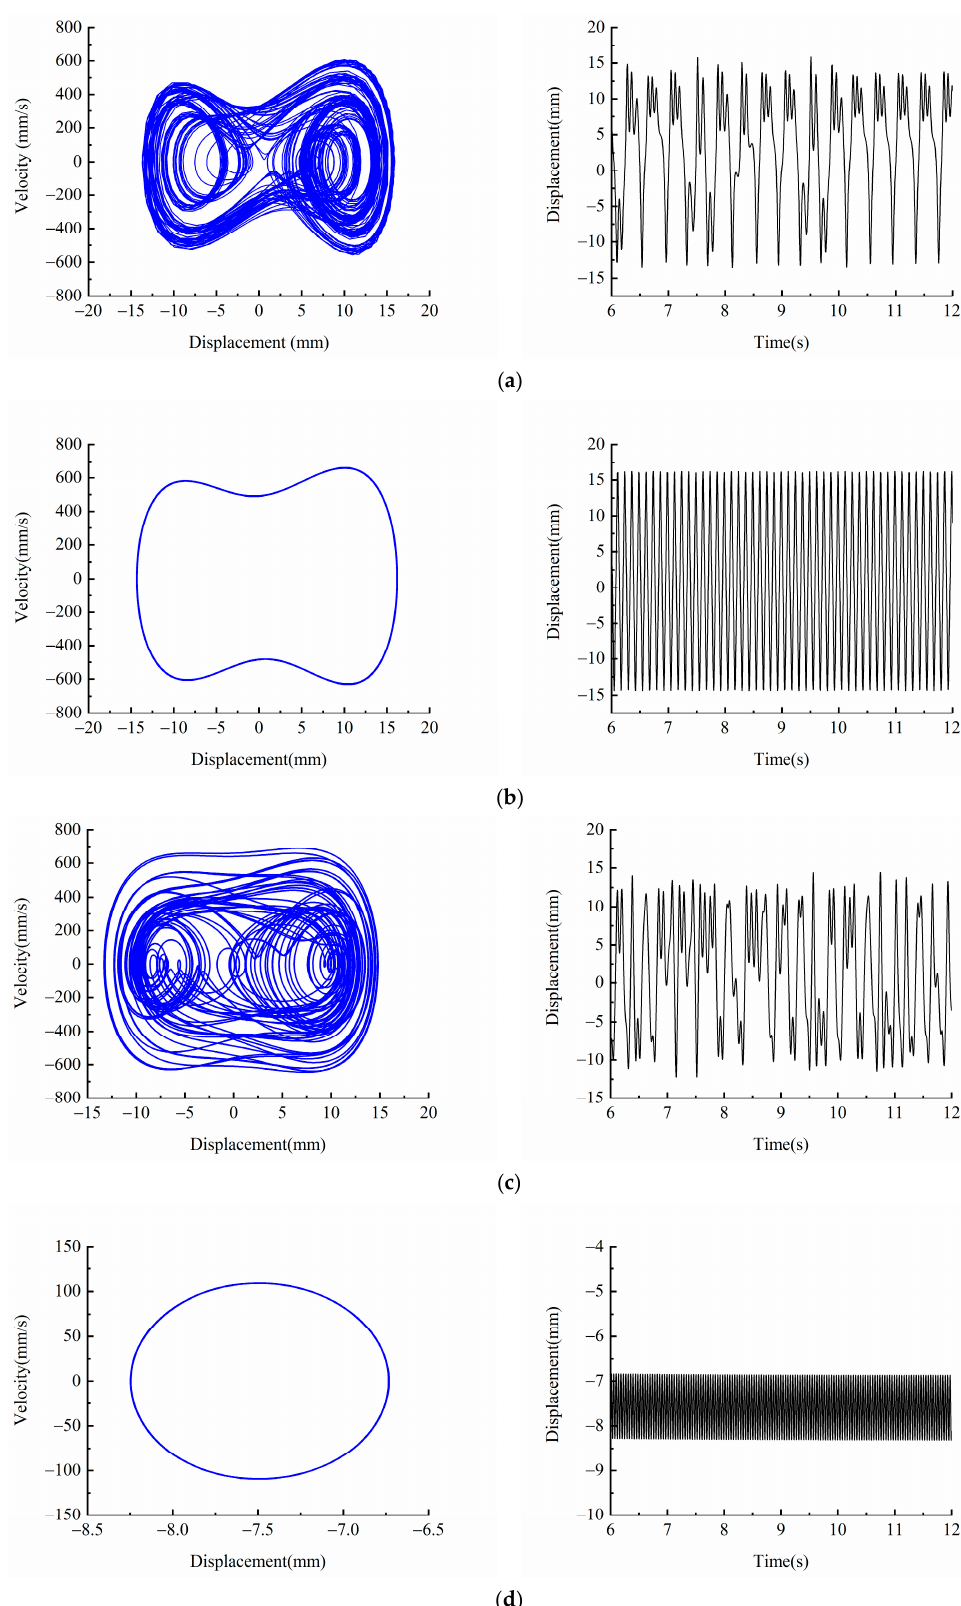
Figure 8. Phase portrait and time-displacement diagram of different excitation frequency 𝑓 : ( a ) 𝑓 = 2.5 Hz ; ( b ) 𝑓 = 8 Hz ; ( c ) 𝑓 = 12 Hz ; ( d ) 𝑓 = 25 Hz .